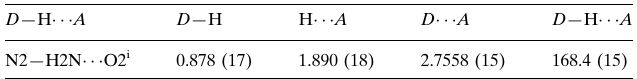
Hydrogen-bond geometry (A˚ , (cid:1)